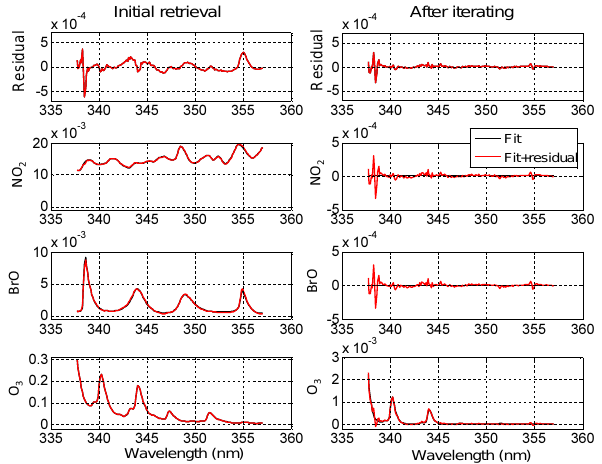
Figure 11. Residual and fitted ODs of the absorbers obtained by the iterative two-step approach in the UV. The spectra are simulated for the same scenario (limb observation in subarctic atmosphere in spring) as for previous figures. Left panel: initial DOAS fit for a spectrum at TH = 19.83km; right panel: fit for the corrected spec- trum (original spectrum corrected by subtracting the spectrum cal- culated from profiles retrieved in the last iteration).